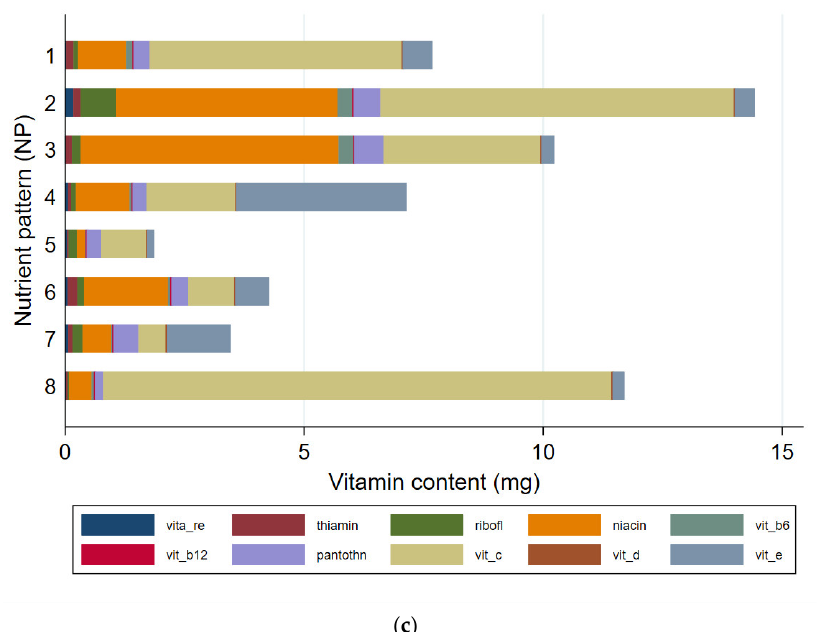
Figure 3. Median nutrient values per nutrient pattern (NP) for ( a ) macronutrients; ( b ) minerals and ( c ) vitamins.